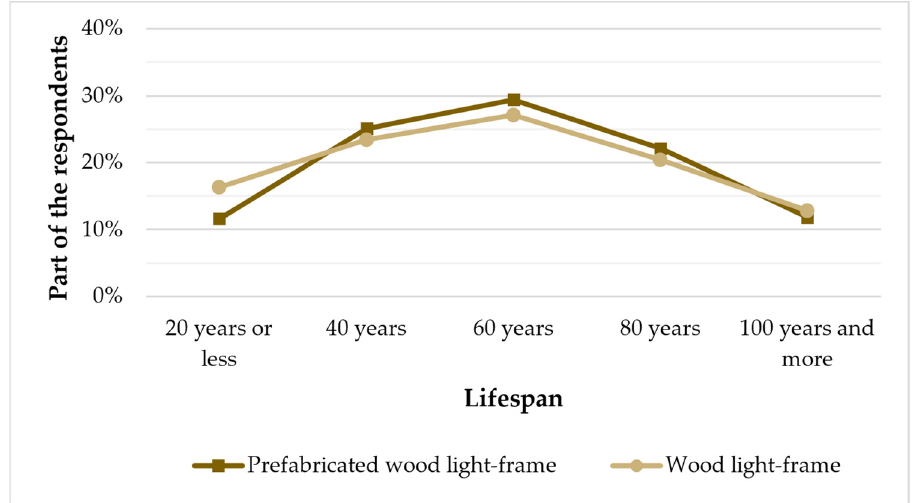
Figure 6. Comparison of the perceived lifespan of a prefabricated light-frame wood building with an on-site light-frame wood building.